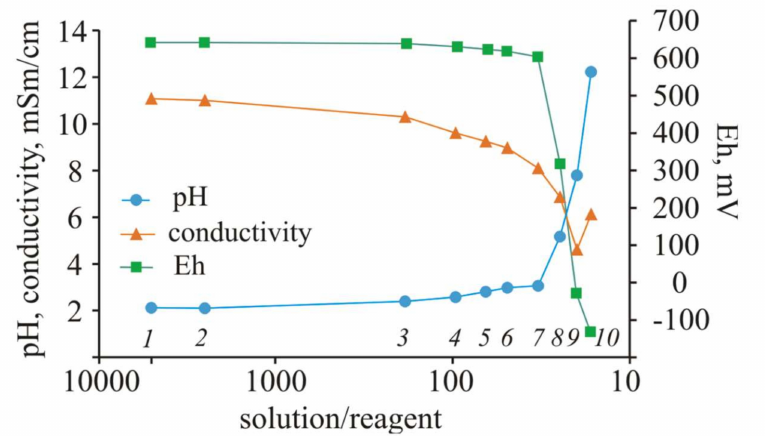
Figure 2. Changes in the physicochemical conditions and EC during the experiment with Ca(OH) 2 . Hereinafter, the italic numbers above the abscissa axis indicate the steps of the experiment. At the experiment with Ca(OH) 2 , physico-chemical parameters and element concentrations were measured at solution / reagent ratios (S / R): 1 —5000; 2 —2500; 3 —185; 4 —96; 5 —65; 6 —49; 7 —33; 8 —25; 9 —20; 10